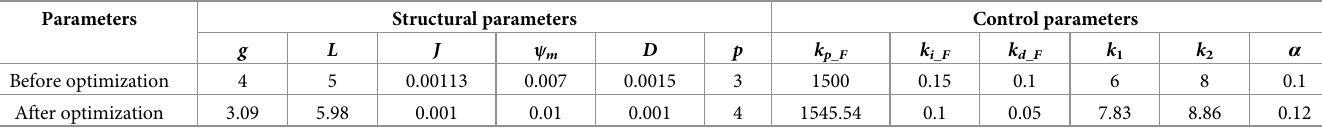
Table 10. Comparison of the decision